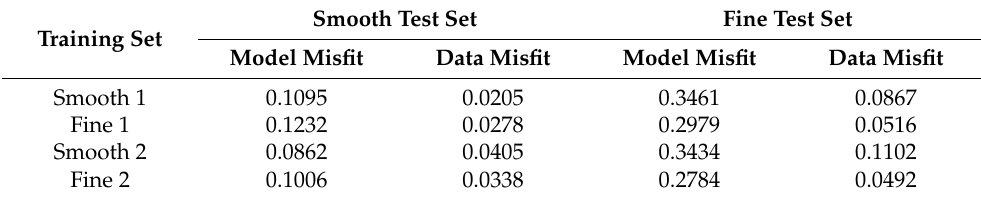
Table 1. Mean model and data misfits of test sets for the general smooth and the proposed fine sample sets.